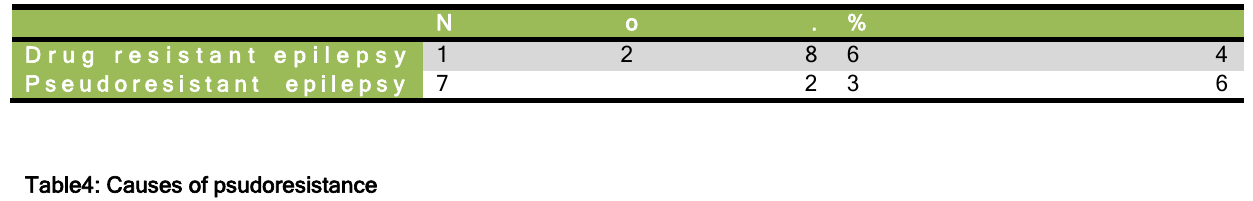
Table4: Causes of psudoresistance P o o r 6 3 6 . 1